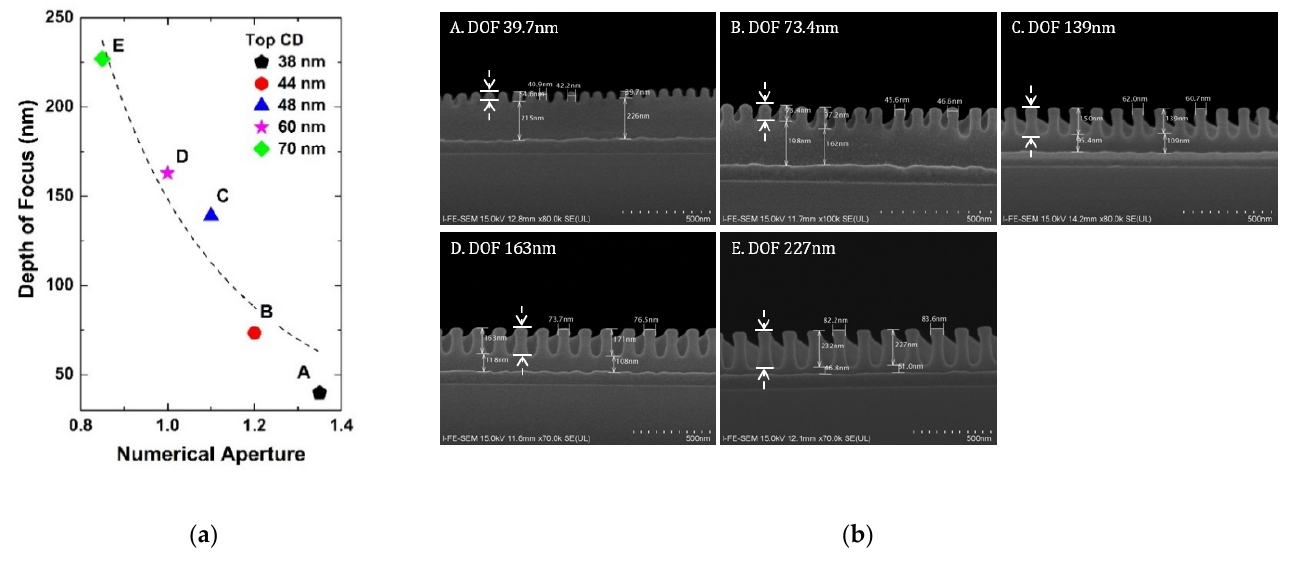
Figure 2. ( a ) Extracted results of the depth of focus according to NA . At each NA , the critical dimension is the best (maximum) resolution; ( b ) FE-SEM of 1:1 line and space pattern (cross view) with the best resolution at each NA condition. Here, the thickness of the photoresist is enlarged to 2400 Å to find out the depth of focus experimentally. The dashed arrows indicate the depth of